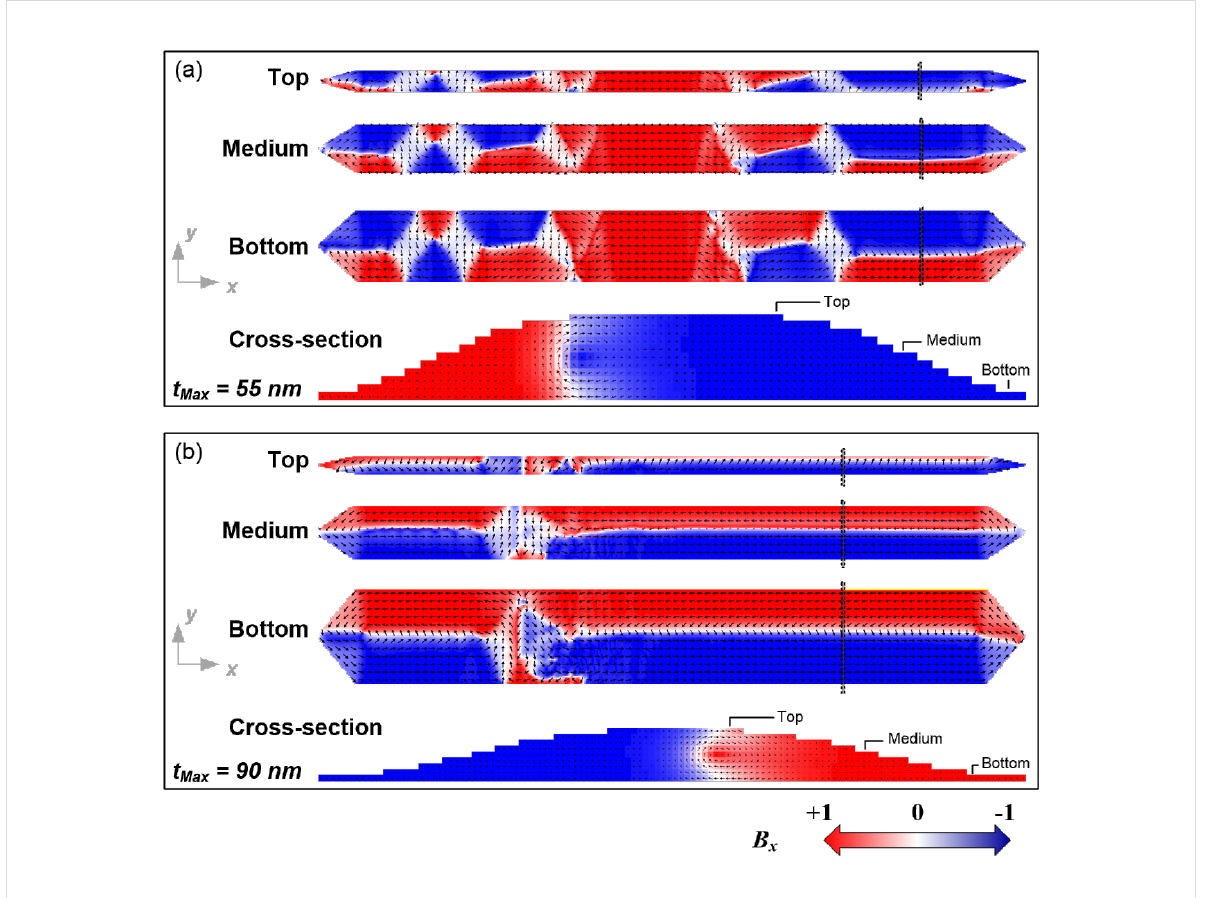
Figure 10: Magnetization vector-color maps extracted from the simulations for 250 nm wide Fe nanowires with bell-shaped profile (case II) and nominal thicknesses of (a) 30 nm and (b) 50 nm. The areas marked with black lines in the x , y plane representations have been chosen for the repre- sentation in the y , z plane (cross-section).